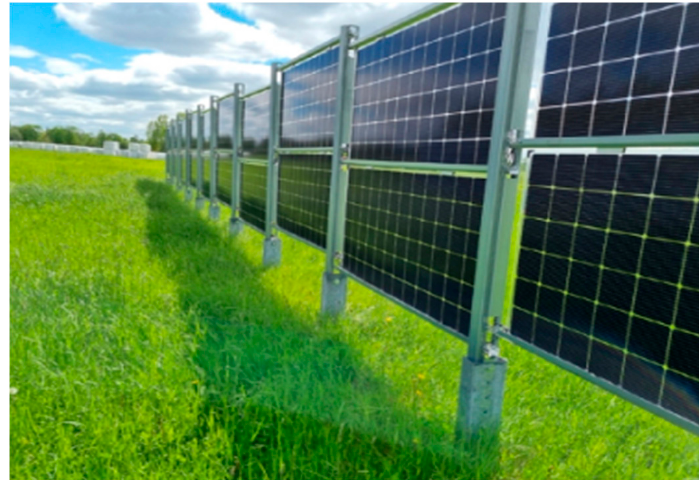
Figure 8. Vertical agrivoltaic installation with bifacial modules in Sued [62].